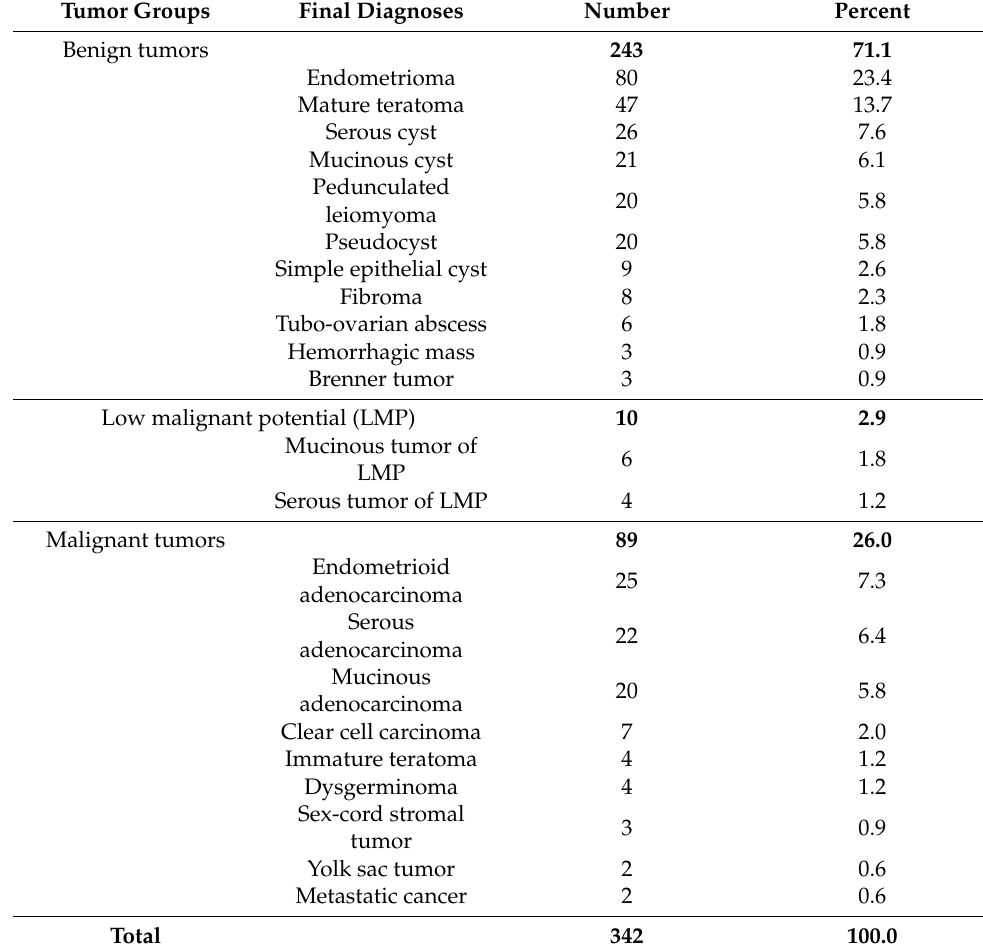
Table 1. Frequencies of the adnexal masses according to final diagnosis.